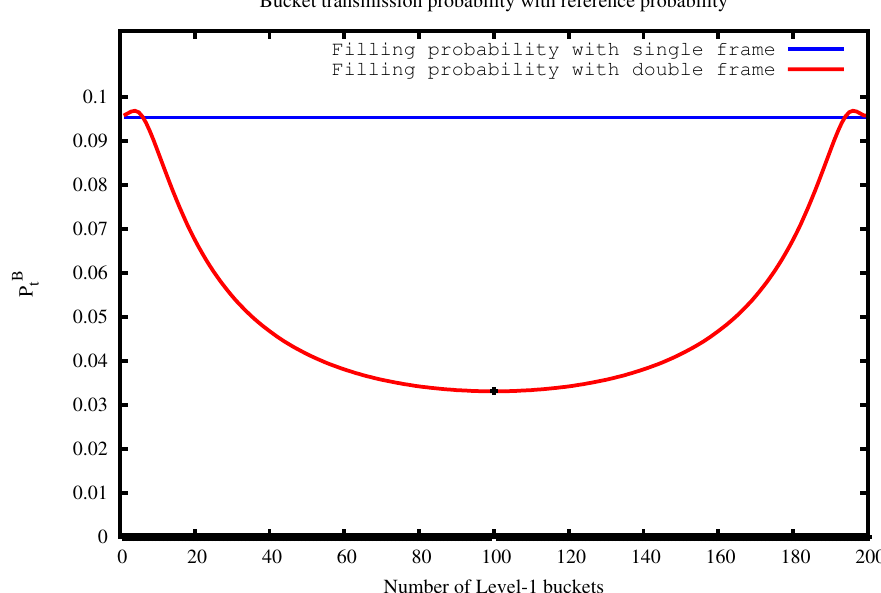
Figure 3. Bucket transmission probability using single and double